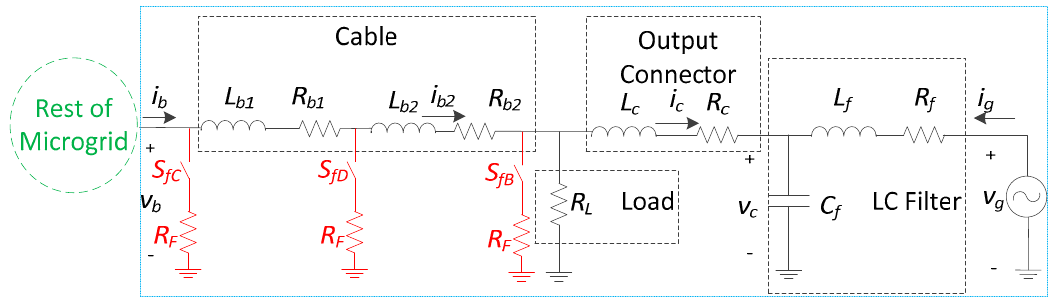
Figure 3. Microgrid feeder circuit during normal operation (switches OPEN) and during faulted conditions (specific switches CLOSED).